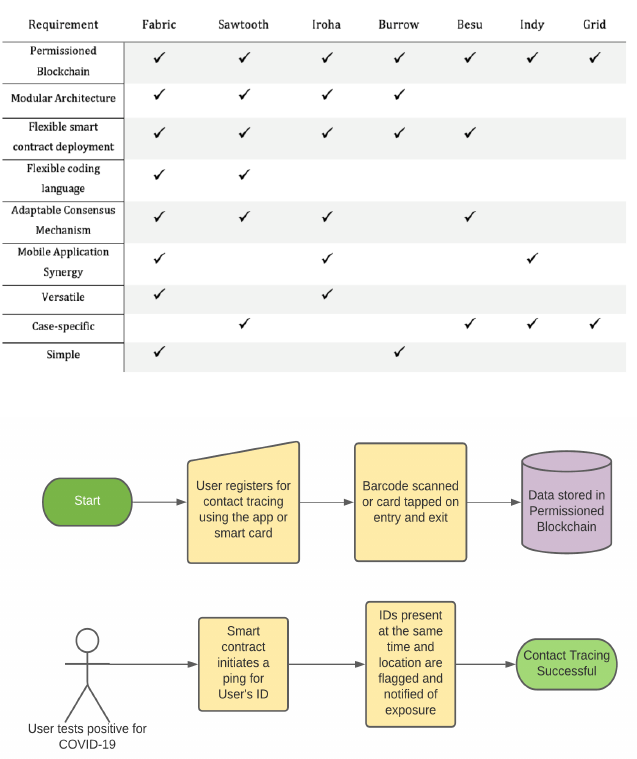
Table 1: Characteristics of Hyperledger Frameworks